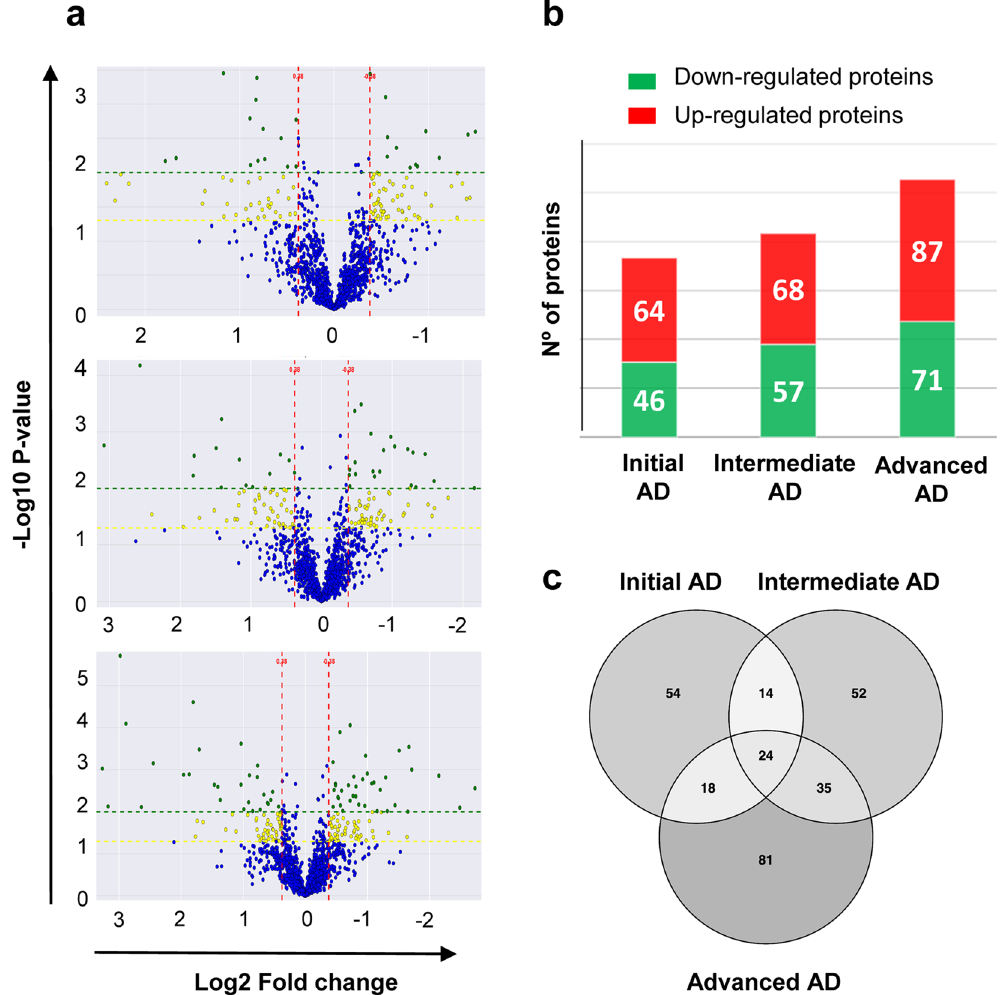
Figure 1. Differentially expressed proteins in the OB across AD-related phenotypes. ( a ) Volcano plots representing the fold-change of identified proteins with associated P values from the pair-wise quantitative comparisons of control vs initial AD stage (upper panel), control vs intermediate AD stage (middle panel), and control vs advanced AD stage (lower panel). In green, very significantly changed proteins (P < 0.01), in yellow, significantly changed proteins (P < 0.05) and in blue, unchanged proteins between the pair-wise comparisons. ( b ) Differential olfactory proteome distribution across AD stages. ( c ) Venn diagram of common and unique differential proteins between AD stages. The distribution of common and distinct proteins in initial, intermediate, and advanced stages is